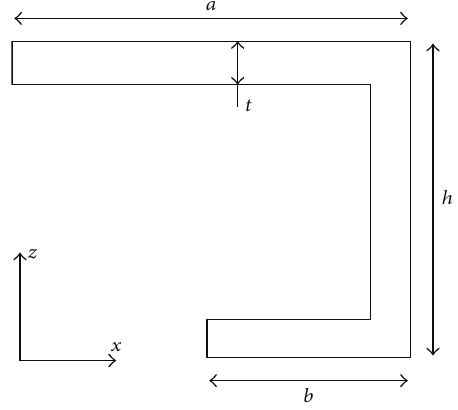
Figure 7: Cross-section of the C-shaped